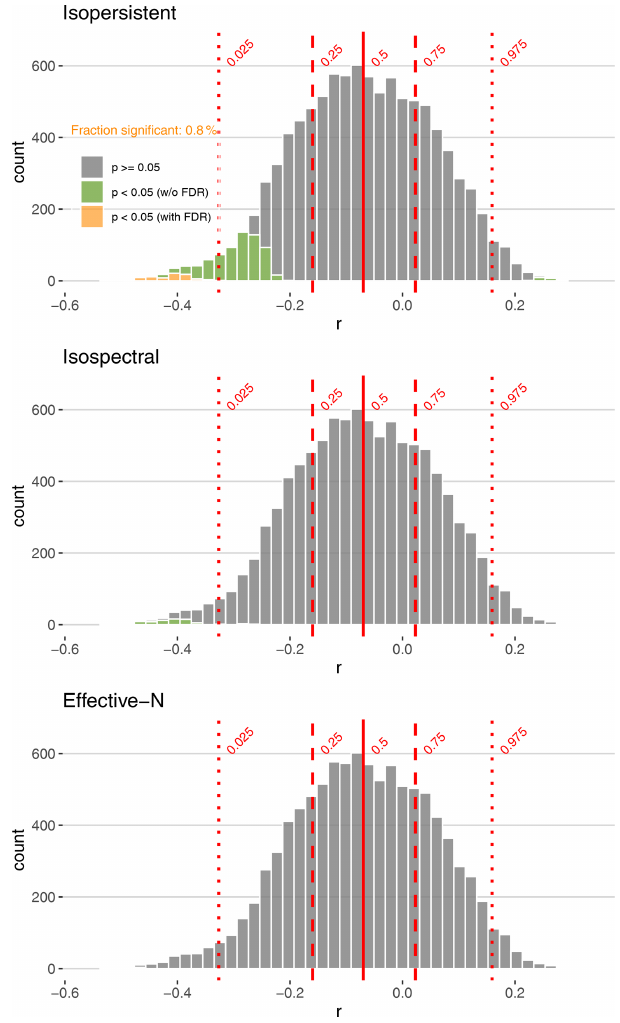
Figure 4. Distribution of age-uncertain correlation between Hulu Cave speleothem and GISP2 ice core δ 18 O. Significant (insignifi- cant) correlations are shown in green (gray). Correlations that re- main significant after adjusting for false discovery rate (FDR) are shown in orange. Quantiles of the distribution are indicated by ver- tical red lines.